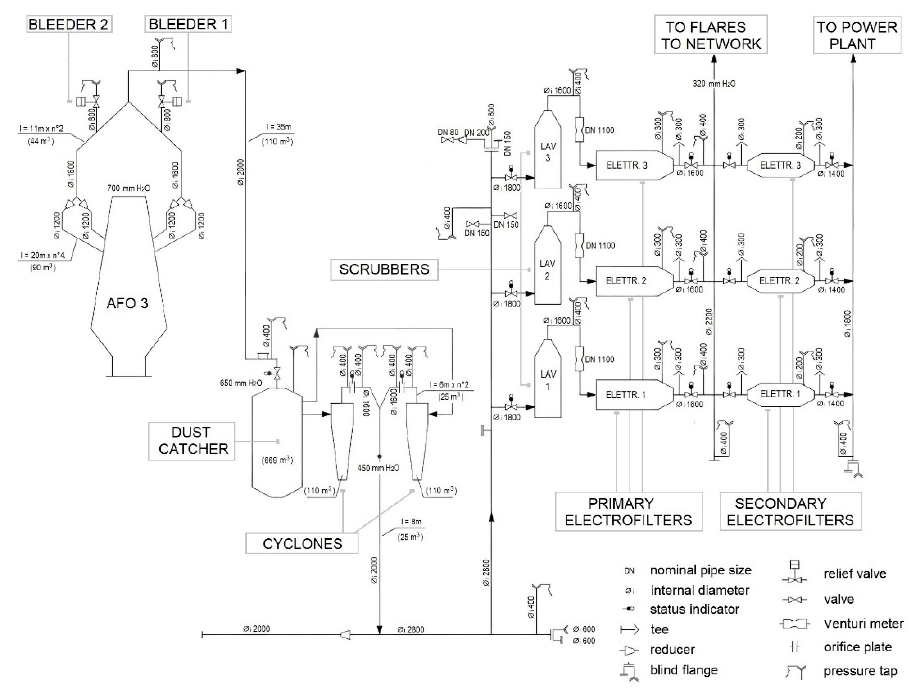
Figure 3. BF gas treatment system.